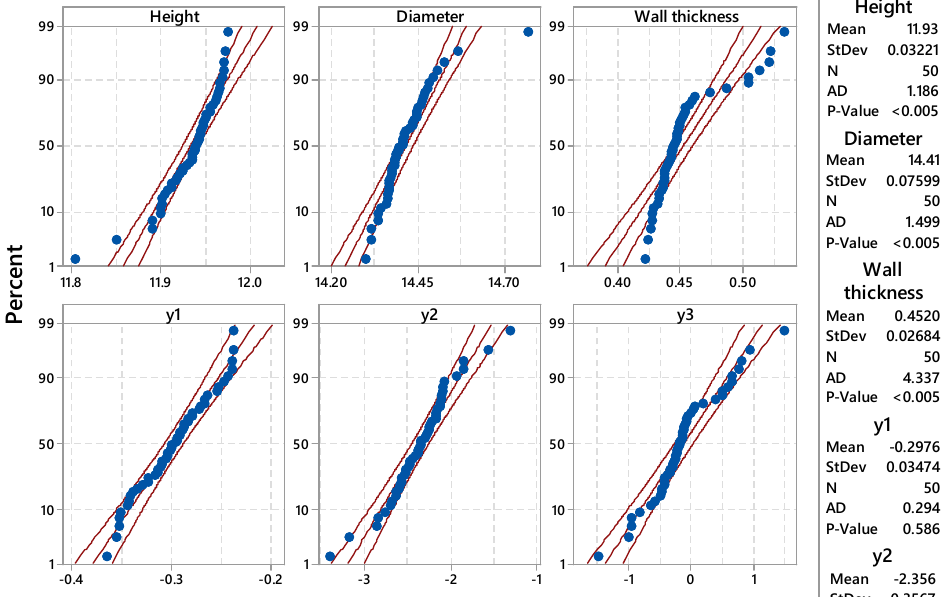
Figure 7. Normality plots for height, wall thickness, and diameter characteristics. Table 7. Skewness of the original and transformed data.